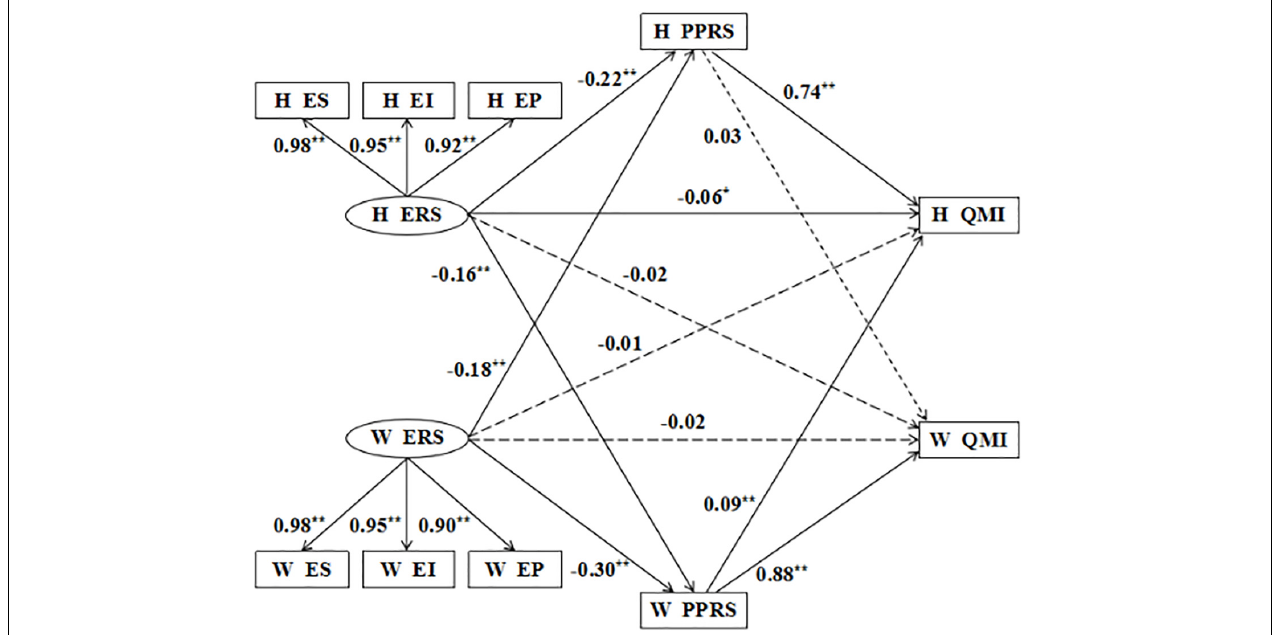
FIGURE 3 | Mediating effect of perceived partner responsiveness. H, husbands; W, wives; ERS, emotion reactivity scale; ES, emotion sensitivity, EI, emotion intensity; EP, emotion persistence; PPRS, perceived partner responsiveness scale; QMI, quality of marriage index.** p < 0.01.